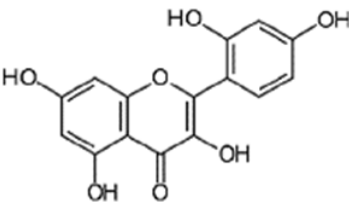
Figure 13. Chemical structure of Morin